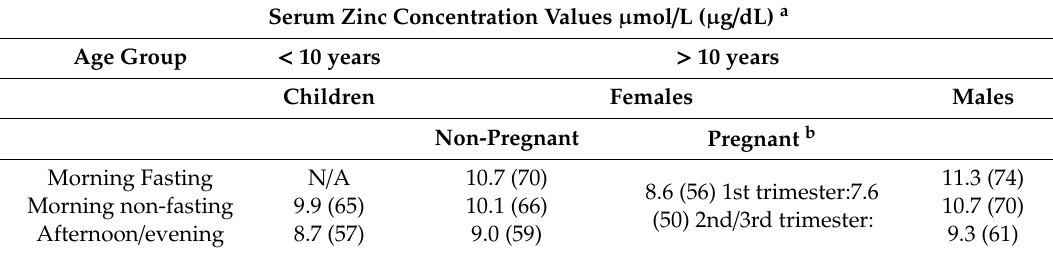
Table 1. Recommended lower cut-o ff s (2.5th percentile) for serum zinc status, adapted from the National Health And Nutrition Examination Survey (NHANES) II data